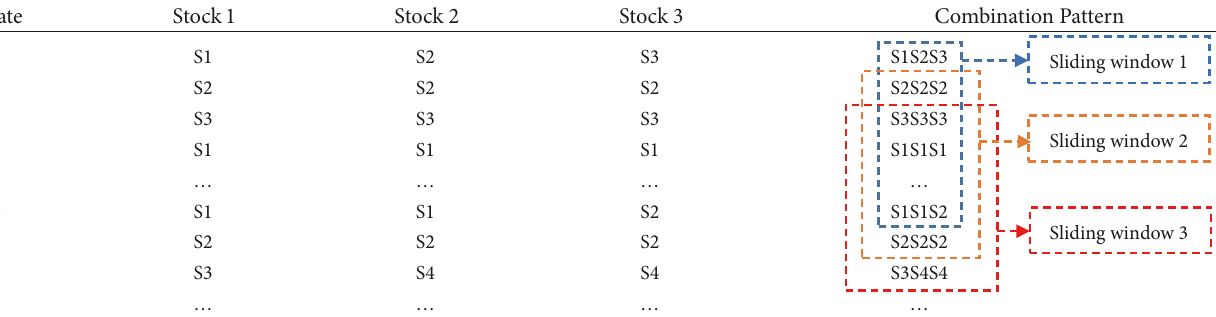
Table 1: The process of using the sliding